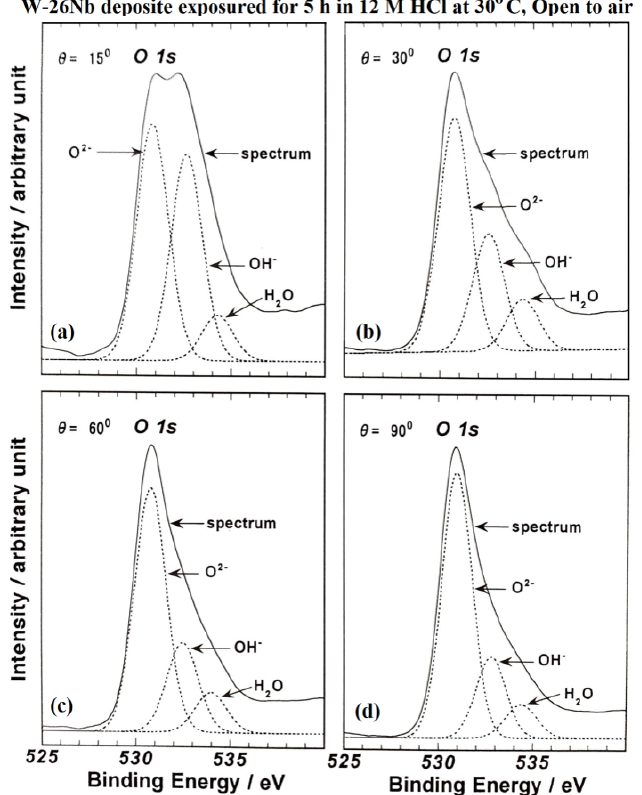
Figure 6: Deconvoluted O 1s spectra for W-26Nb deposit at (a) 15°, (b) 30°, (c) 60° and (d) 90° of TOA ( θ